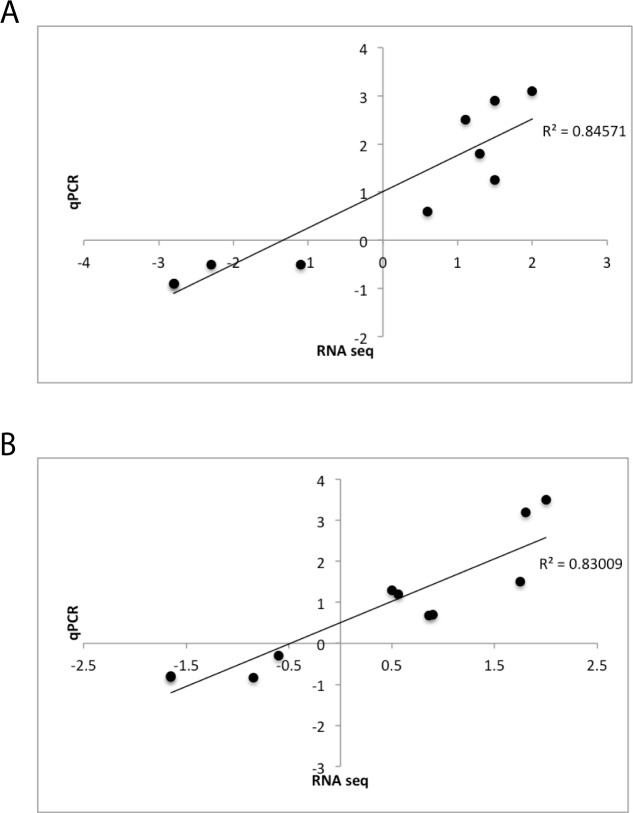
qPCR validation of representative DEGs at 2 and 5 hrs MET-treatment.Panel A: Plot of nine genes, found to be significantly affected after 2 hr of MET, showing RNAseq derived fold change (FC) (x-axis) vs. qPCR derived FC (ΔΔCt) (y-axis). Panel B: Plot of ten genes, found to be significantly affected after 5 hr of MET, showing RNAseq derived FC (x-axis) vs. qPCR derived FC (y-axis). Each point is the mean derived from three unique replicate biological samples. Linear regression (R2) values are shown inside each plot (p<0.001 for each panel).